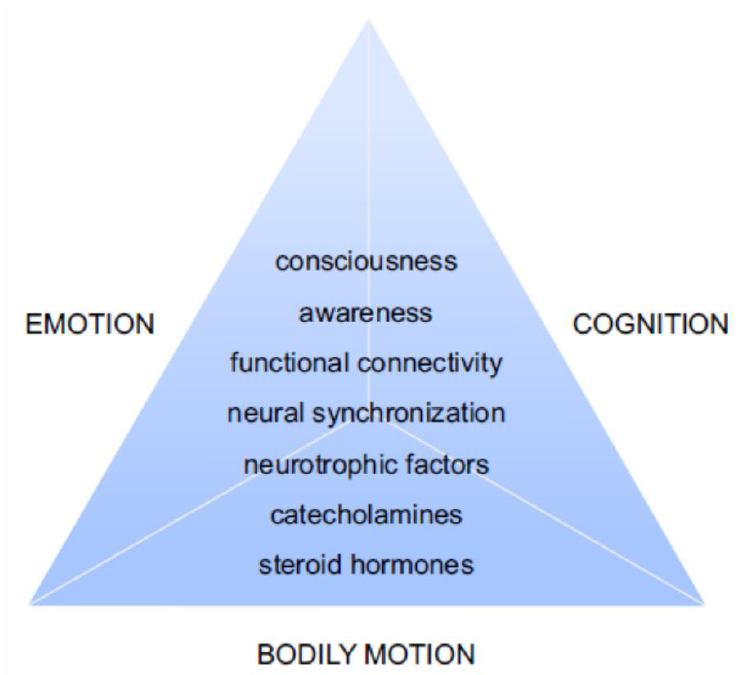
Figure 1. The interconnectedness between motion, emotion and cognition and the possible dimen- sions that need to be examined in order to achieve a comprehensive overview of the effects of training. Adapted from [17,18].